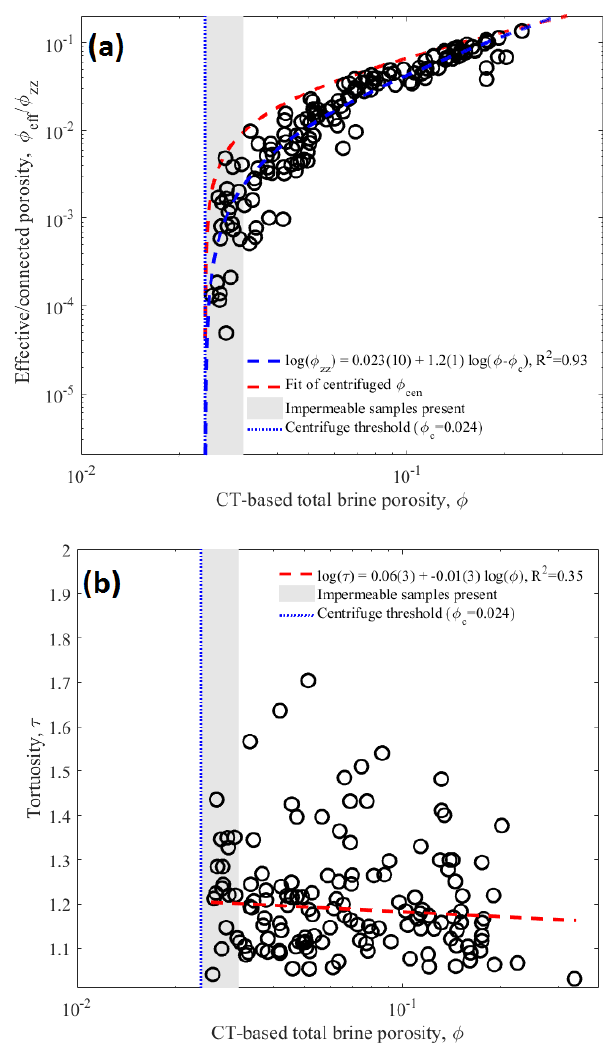
Figure 9. (a) Relationship between CT-based connected porosity φ zz and total brine porosity in comparison to the centrifuge-based fit of the open porosity φ cen . (b) Tortuosity of the flow based on the length of the path of the channel with maximum diameter.